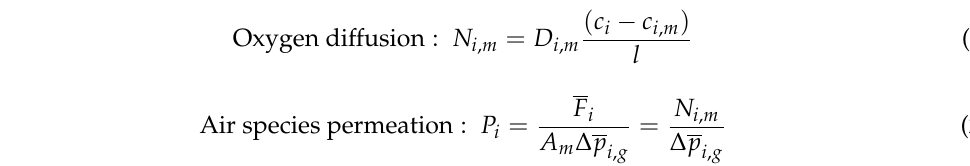
Figure 28. Schematic of the computation domain of a Li-air battery during discharge operation. ( a ) Li-air battery operation with ambient air feeding. Inset demonstrates the formation of discharge Figure 27. Cyclic performance (discharge capacity and capacity retention against cycle number) of a products, such as Li 2 O 2 and Li 2 CO 3 , covering the porous carbon surface; ( b ) Li-air battery protected by an oxygen-selective membrane at the cathode. Reprinted from Sahapatsombut et al. [38], with 10-cycle rechargeable Li-air battery considering Li 2 CO 3 formation by electrolyte degradation. permission from Elsevier. Reprinted from Sahapatsombut et al. [37], with permission from Elsevier.